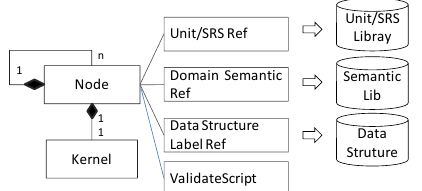
Figure 3 Design of semantic enhanced UDX schema